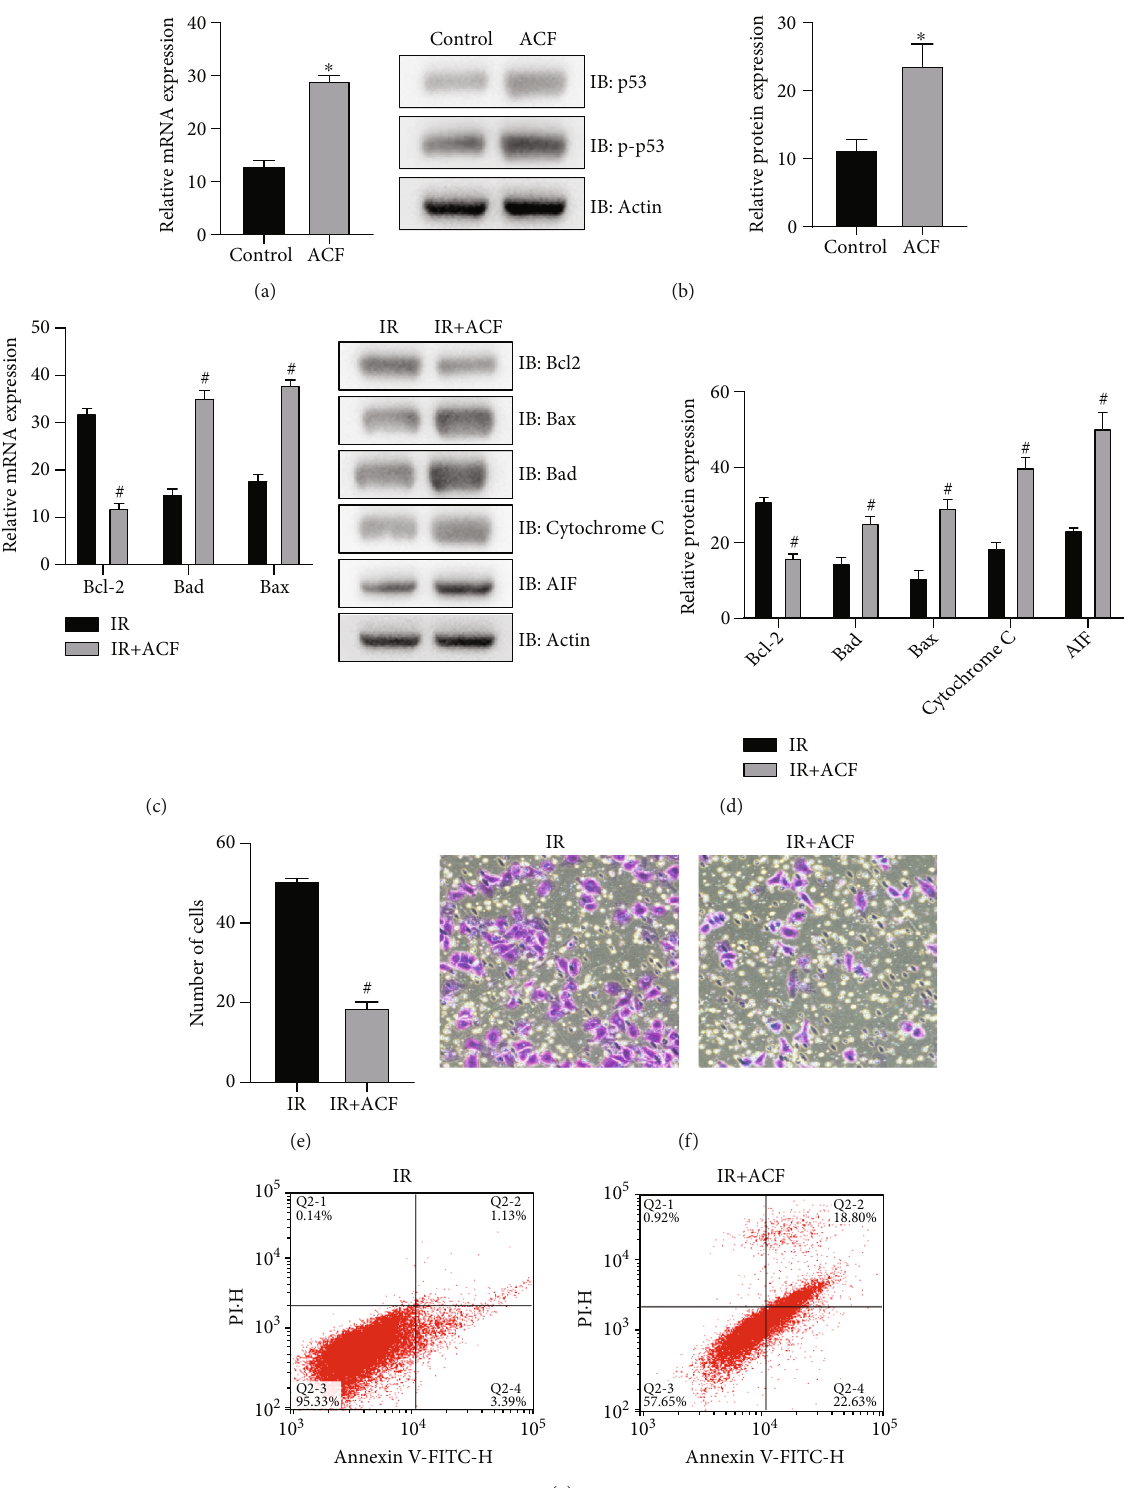
Figure 2: ACF promotes the expression and activation of p53, a ff ects the mitochondrial function of colon cancer cells, and enhances radiosensitivity. (a) The expression of p53 mRNA was increased after ACF treatment. (b) The expression level of p53 became higher after ACF treatment. (c) After ACF treatment, there was a lower the mRNA expression of Bcl-2 and higher mRNA expression levels of Bad and Bax. (d) After ACF treatment, the expression of Bcl-2 decreased, and the expressions of Bad, Bax, AIF, and cytochrome C increased. (e) The proliferation ability of SW620 cells was weakened. (f) The invasion ability of SW620 cells was inhibited. (g) Apoptosis of SW620 cells was enhanced. ∗ P < 0 : 15 , compare with the control group. # P < 0 : 15 , compare with the IR